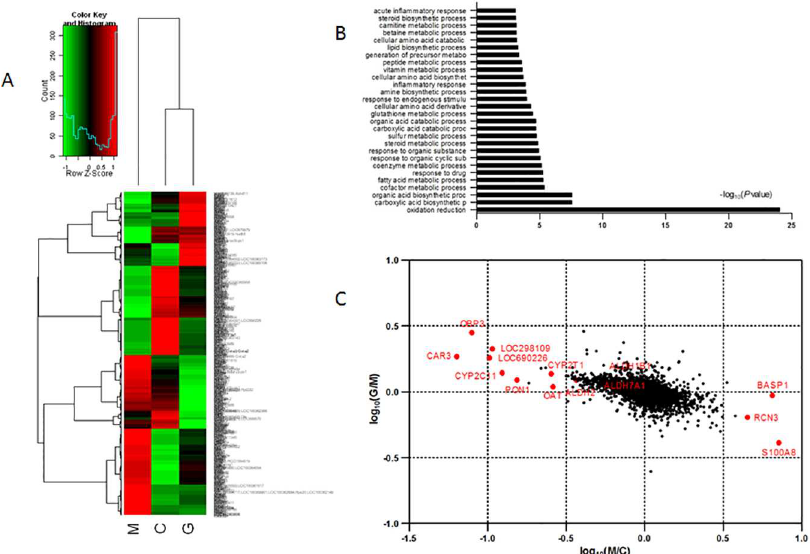
Fig 2. Proteomics analysis of gypenoside-treated liver fibrosis rats. (A) Heatmap of the significantly altered proteinsin control, model and gypenoside group. Red represents an up-regulation, and green represents a down-regulation in protein expression. The proteins were clusteredinto four broad clusters. (B) Representative Gene Ontology (GO) biological processes ( P < 0.001) of differentiallyexpressedproteins betweengypenoside and model groups. (C) Log-logplot of the two conditionsM/C and G/M basedon protein expressionratios. Outstandingprotein expressionchangesare indicatedaccordingto their gene names. (C: control group; M: liver fibrosis model group; G: gypenoside